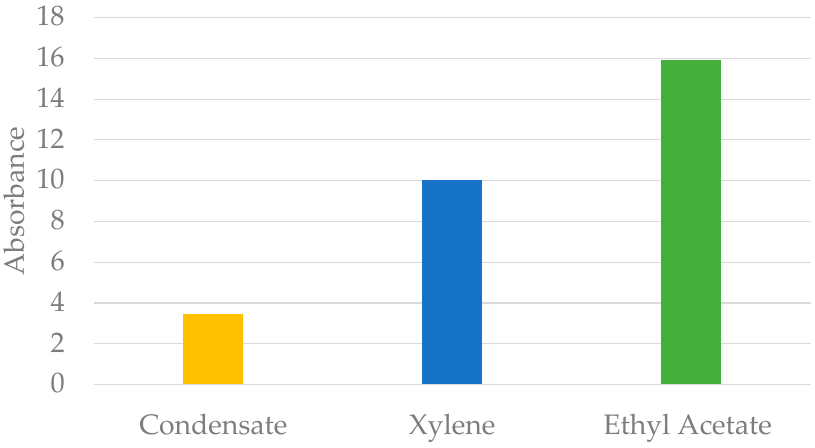
Figure 5. UV-VIS absorbance of extracted soak solvent at 1.5 h of soaking time.